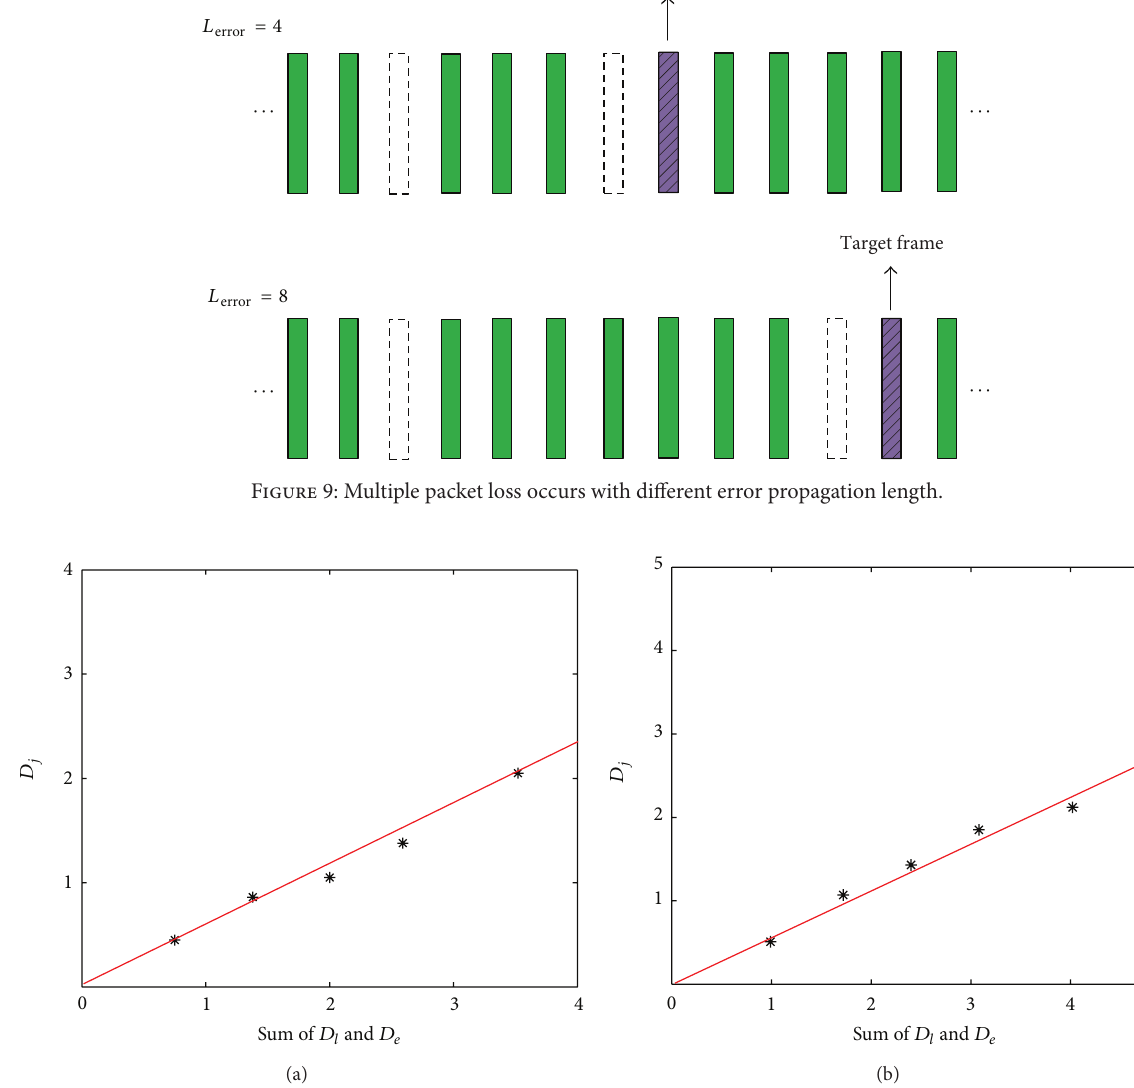
and all the values of frame quality form the training set